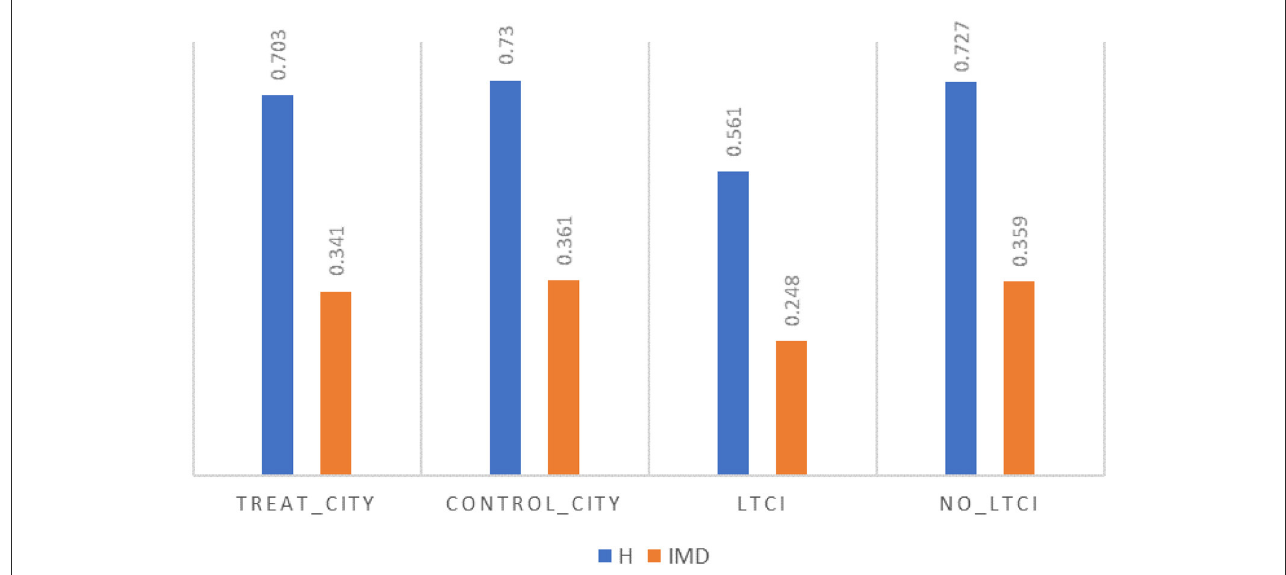
FIGURE2 Decomposition of MPI by study